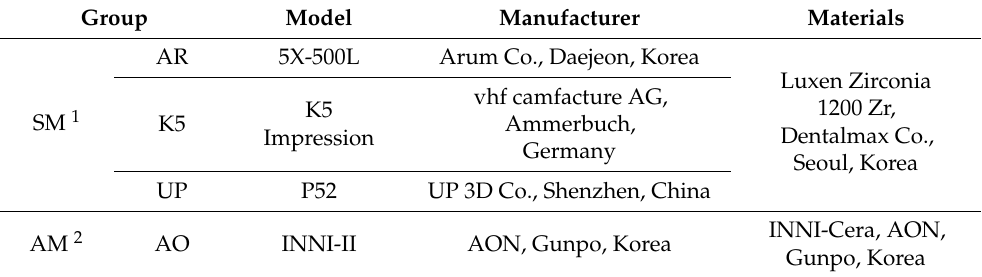
Table 1. Devices and materials used in this study. Group